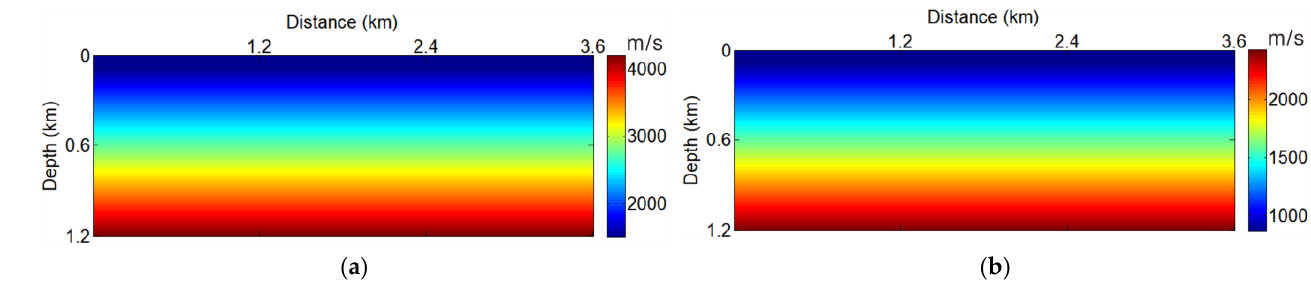
Figure 5. Initial velocity models; ( a ) V p ; ( b ) V s .